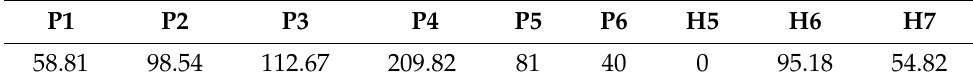
Table 8. Optimal schedule for the best cost obtained for Case study